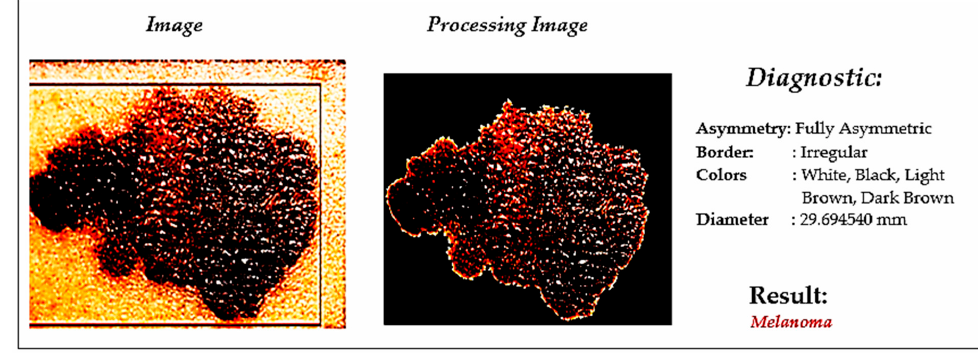
Figure 4. Skin cancer detection using ANN [19]. Table 3. A comparative analysis of skin cancer detection using ANN-based